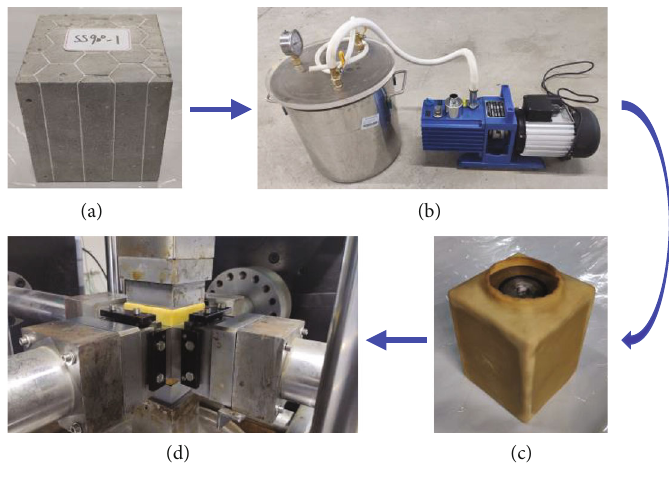
Figure 4: Sample installation process.